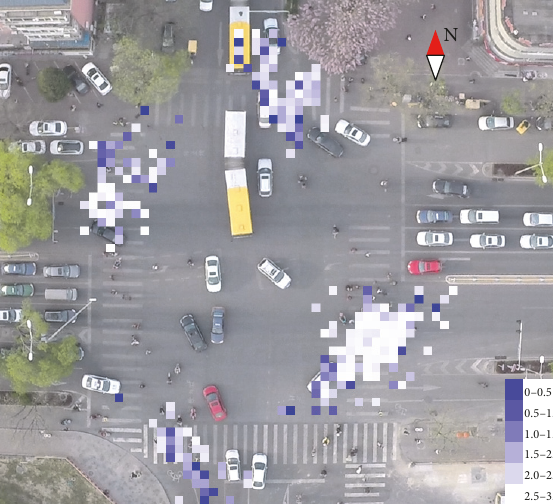
Figure 12: Spatial distribution of RTTC min .